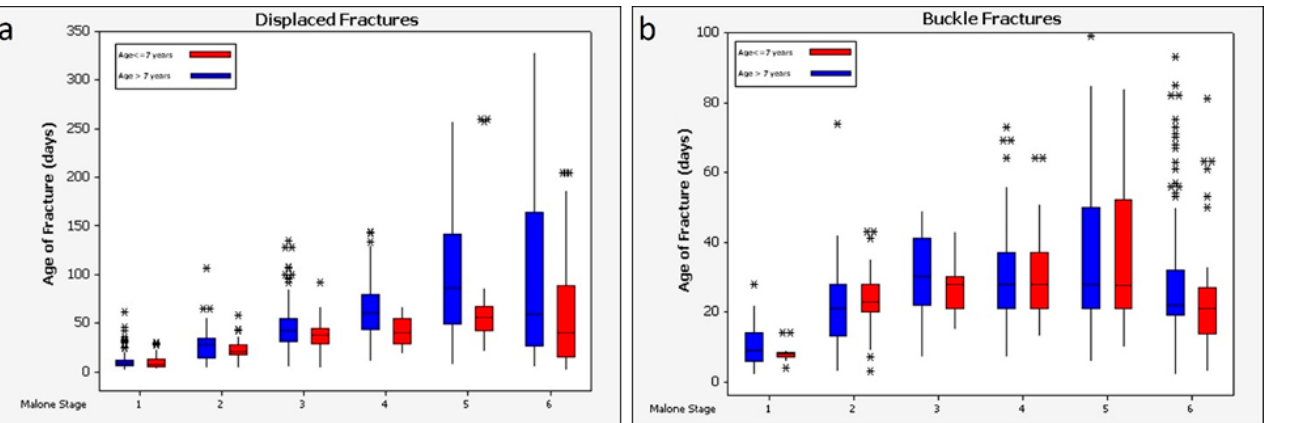
Figure 4. Relative contribution of variables to variance in displaced (blue) and buckle (orange) frac- tures.